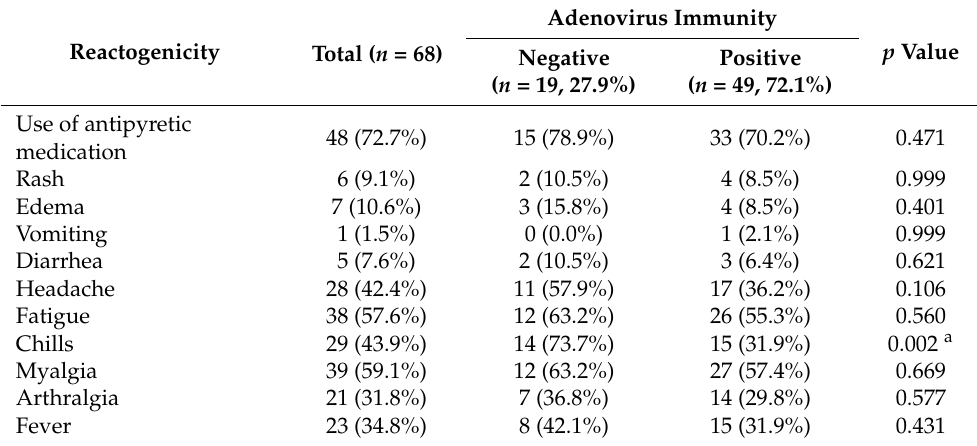
Figure 3. Reactogenicity to ChAdOx1 nCoV-19 vaccination according to pre-existing adenovirus immunity. Table 3. Reactogenicity to the first dose of ChAdOx1 nCoV-19 vaccine according to pre-existing adenovirus